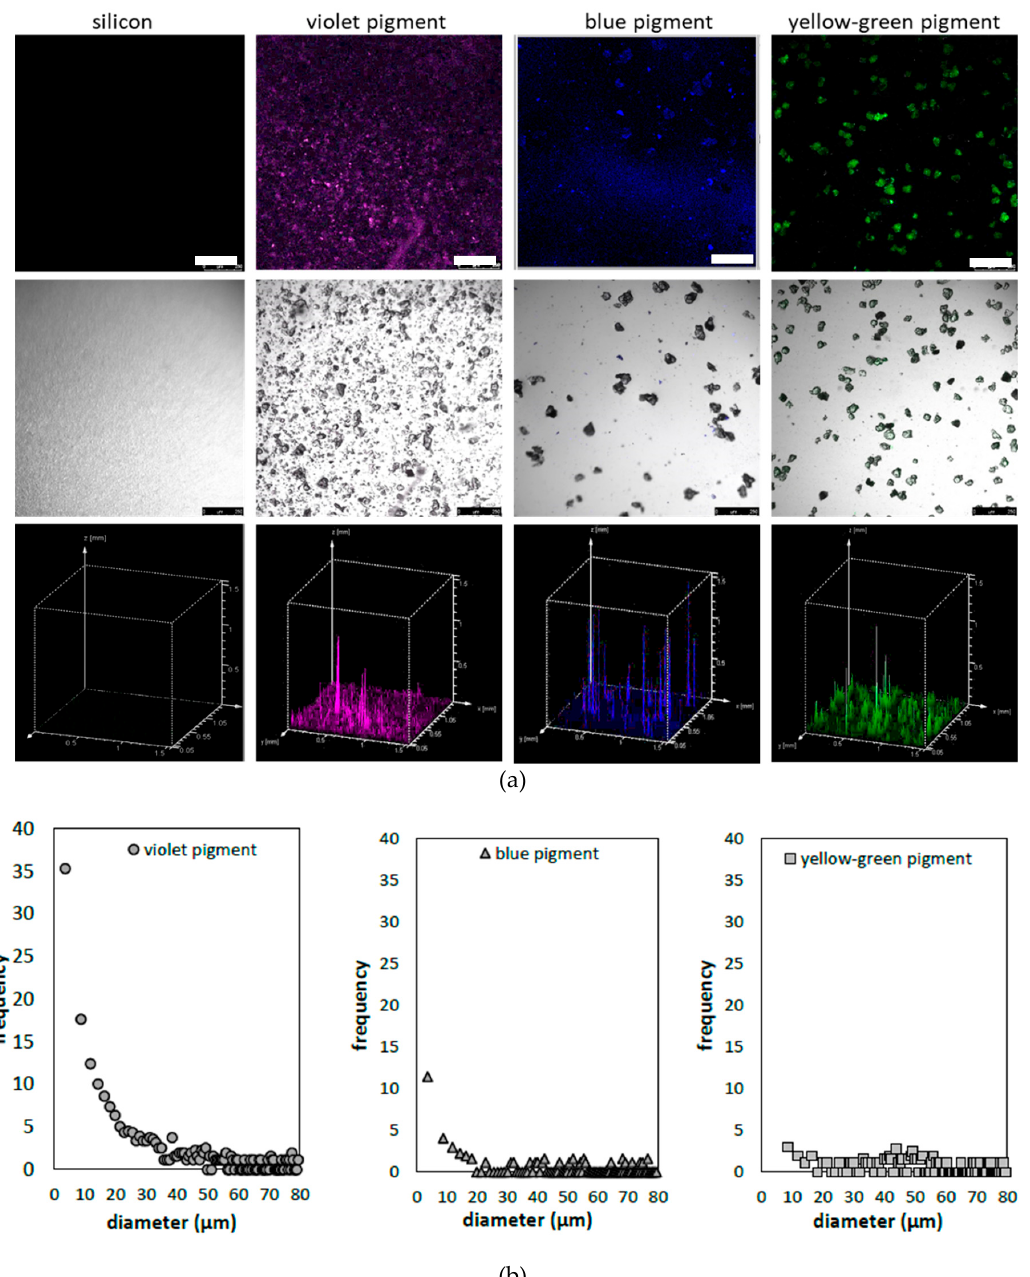
Figure 4. ( a ) Confocal microscopy micrographs of luminescent pigments dispersed within the polydimethylsiloxane (PDMS) binder at 5 wt % concentration. Top: fluorescence channel; centre: fluorescence channel combined with bright field images and bottom topological 3D view, displaying two-dimensional height profiles using the fluorescence intensity as the third dimension. ( b ) Bar diagram for particle size distributions in the violet, blue and yellow green pigments at 5 wt % concentration within the PDMS binder. Data are averaged from 5 micrographs with dimensions 1.5 mm × 1.5 mm. Scale bars correspond to 250 µm.